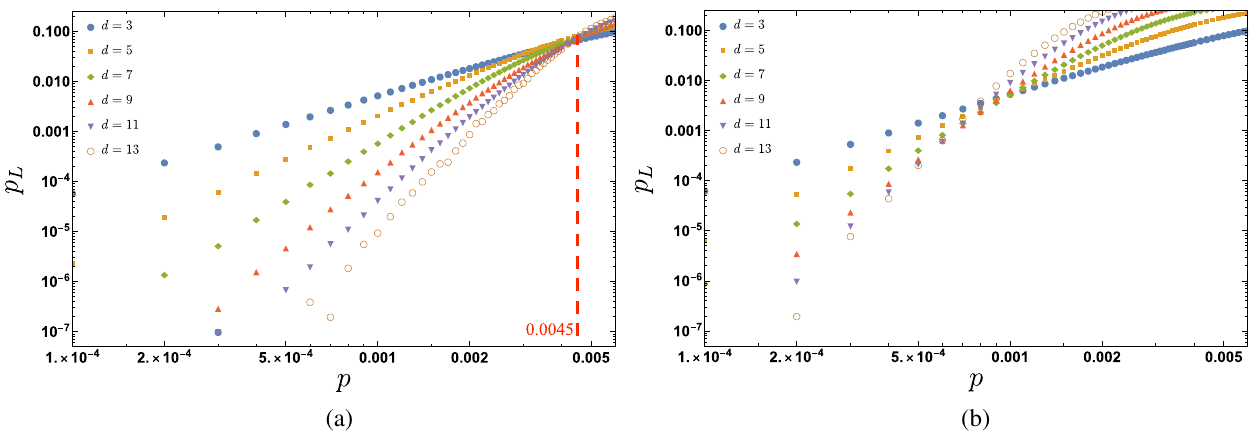
FIG. 16. (a) Logical X -error rates and (b) logical Z -error rates for the heavy-hexagon code. The asymptotic threshold for logical X 0 . 0045 . Since Z errors are corrected using Bacon-Shor-type stabilizers, there is no threshold for Z errors is approximately p th ¼